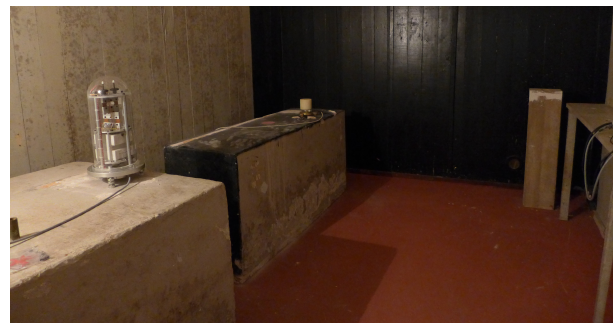
Figure 6. The thermally insulated inner room of the variometer house: the new FGE sensor is placed on the pillar in the front (left), and the LEMI 417 sensor is placed on the pillar in the back. To the right, a part of the shelf with the FGE electronics is